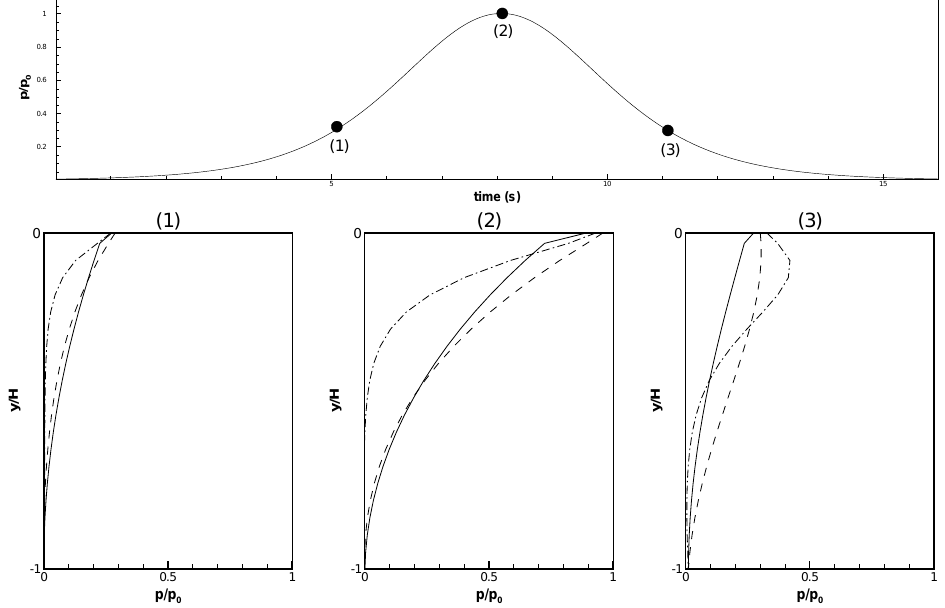
Figure 9. Contours of dimensionless excess pore-water pressure for different permeability coefficients (from top to bottom: k = 2.5 × 10 − 1 , 2.5 × 10 − 2 , 2.5 × 10 − 3 m/s); Young’s modulus E = 2.5 × 10 3 kPa.